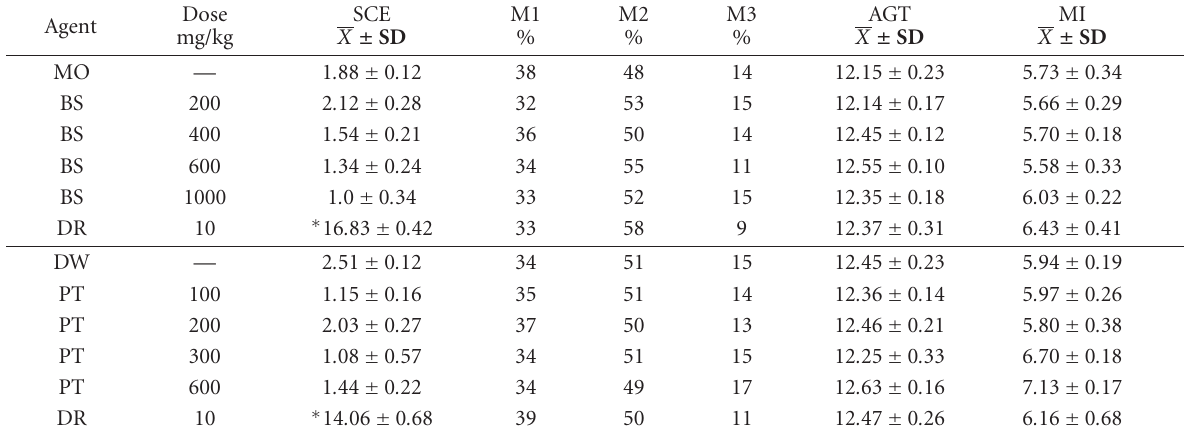
Table 1. Sister chromatid exchanges (SCE), average generation time (AGT), and mitotic index (MI) induced by beta-sitosterol (BS) and pteropodine (PT) in mouse bone marrow cells. MO = mineral oil (0.4mL added to each mouse). DW = distilled water (0.4 mL added to each mouse). DR = doxorubicin. M1 , M2 , M3 = cells in first, second, and third cellular division. AGT = 21(M1+2M2+3M3)